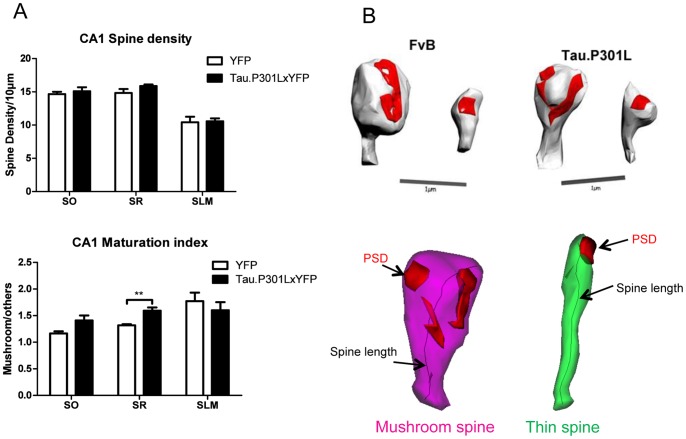
Analysis of dendritic spines in SLM of Tau.P301L mice.A. Dendritic spines in Tau.P301Lx YFP bigenic mice (n = 5) in different brain regions: stratum oriens (SO), stratum radiatum (SR), CA1 SLM as indicated in the captions. Upper panel: spine density is expressed as number of spines per 10 µm of dendritic shaft. Statistical analysis by Student t-Test, unpaired, two-tailed: SO, p = 0.066; SR, p = 0.0068; SLM, p = 0.47. Lower panel: spines maturation ratio, expressed as number of mushroom spines to all spines. Statistical analysis by Student t-Test, unpaired, two-tailed: SO, p = 0.58; SR, p = 0.17; SLM, p = 0.87. B. Representative reconstructions of dendritic spines in wild-type FvB and Tau.P301L mice.